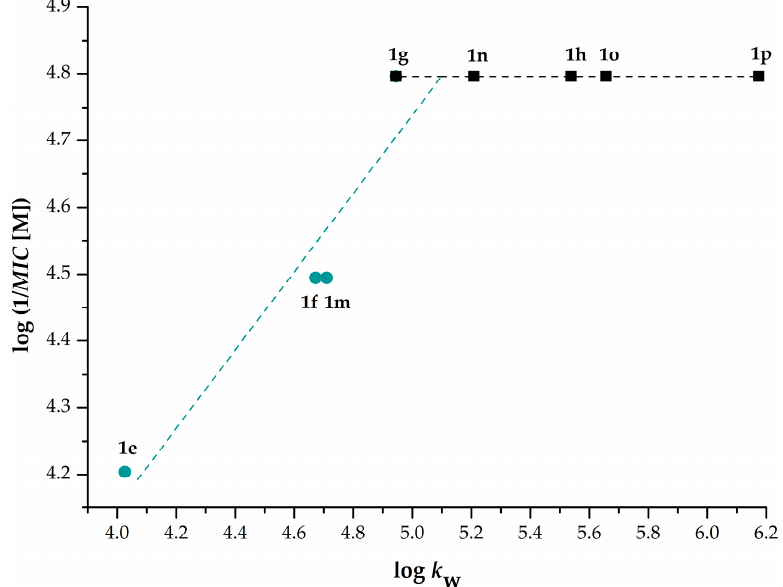
Figure 8. Bilinear relationship between the log k w and log (1/ MIC [M]) parameters resulting from 21-d in vitro screening of the 3-alkoxy substituted compounds 1e – h and 1m – p (alkoxy = butoxy to heptyloxy) against MA 330/80.